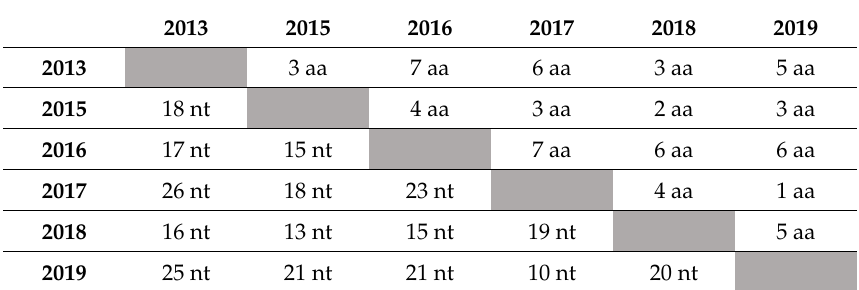
Table 1. Distance matrix from the multiple sequence alignment of six in-farm APPV